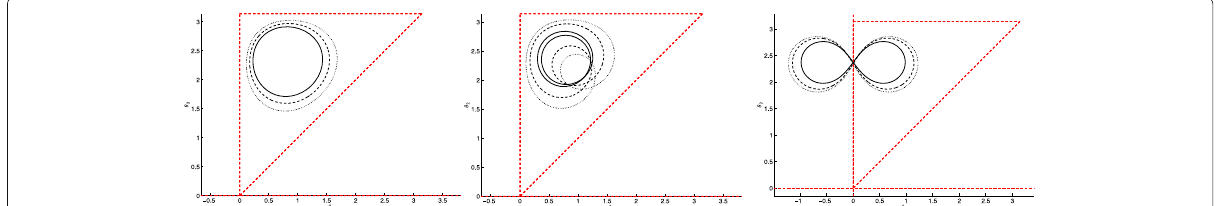
Fig. 12 One parameter family of simple loops, limaçons and Bernoulli lemniscates normal strokes for the Euclidean metric